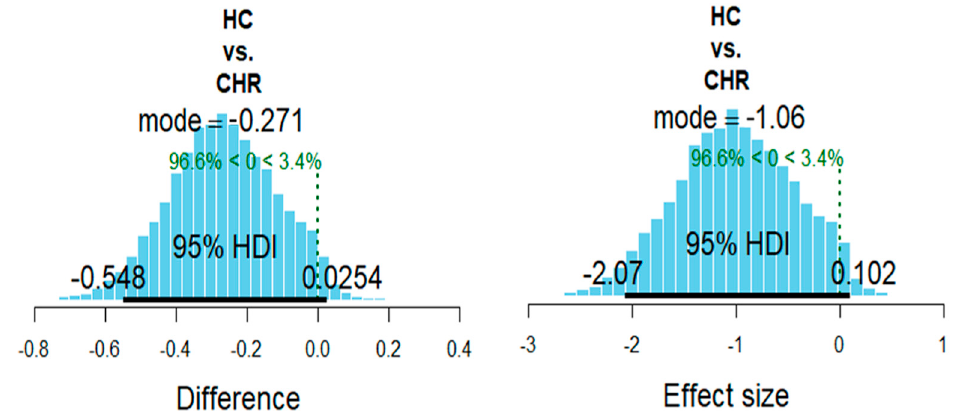
Figure 2. Bayesian analysis. Posterior distributions of the estimated between-groups difference in glutathione.